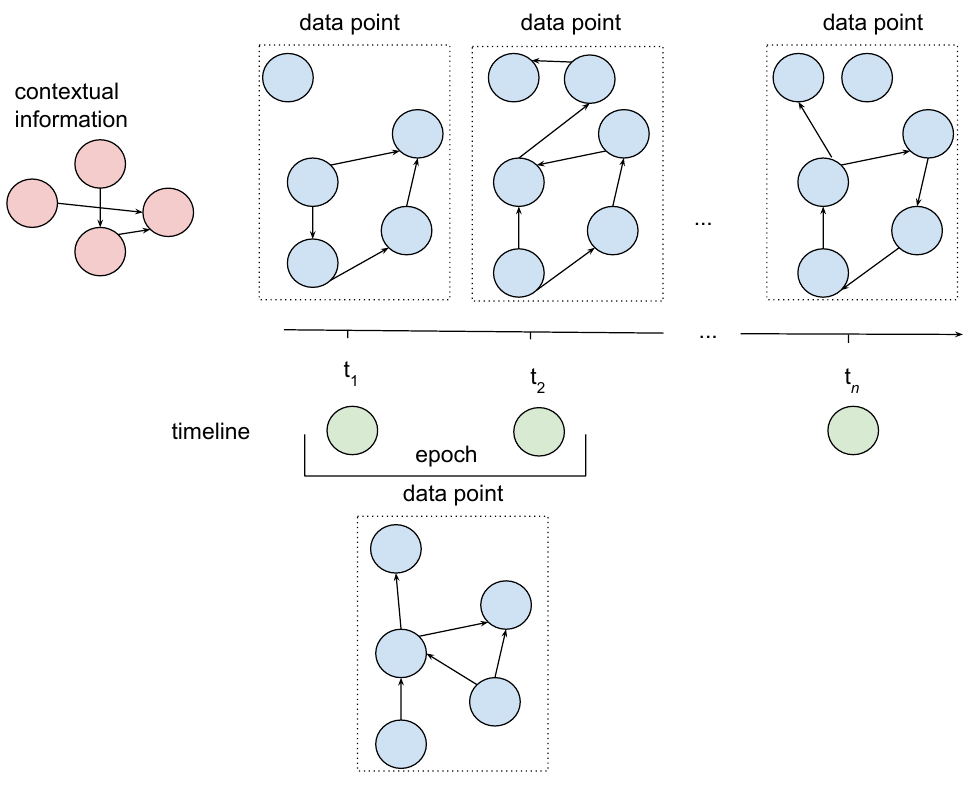
Figure 2. The idea of graph representation. The timeline is presented in green and is understood as a set of time moments or epochs, which are periods of time with a beginning and ending at specified time moments. A single data point, depicted as a set of blue nodes outlined with a dotted line, carries information about values of all measures, acquired from all integrated signals, obtained from all available channels or values representing emotional states. The data point can refer to a single moment of time (in Figure 2, data points above the timeline) or to the specified epoch (in Figure 2, a single data point below timeline). Signals with data points referring to a single moment of time are further called timestamp signals, while signals with data points referring to an epoch are further called epoch signals.